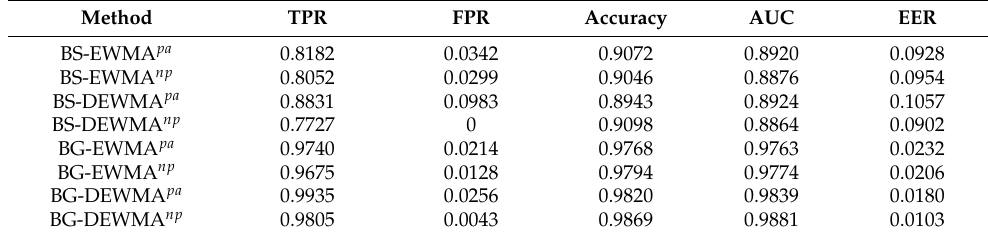
Table 9. Detection results when shading has occurred.